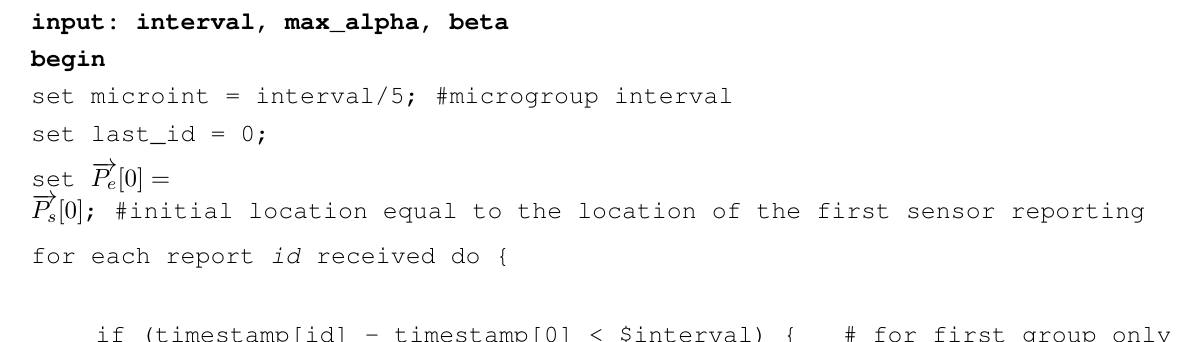
Algorithm 1 Intruder tracking: position estimation